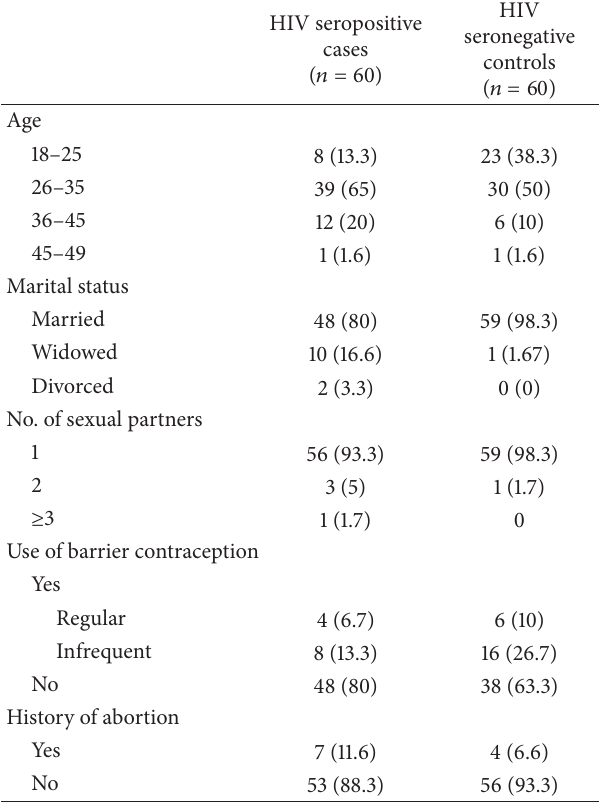
Table 2: Demographic profile of study participants. Table 3: Complaints among symptomatic subjects (A1 + B1) ( 𝑁 = 60 ).